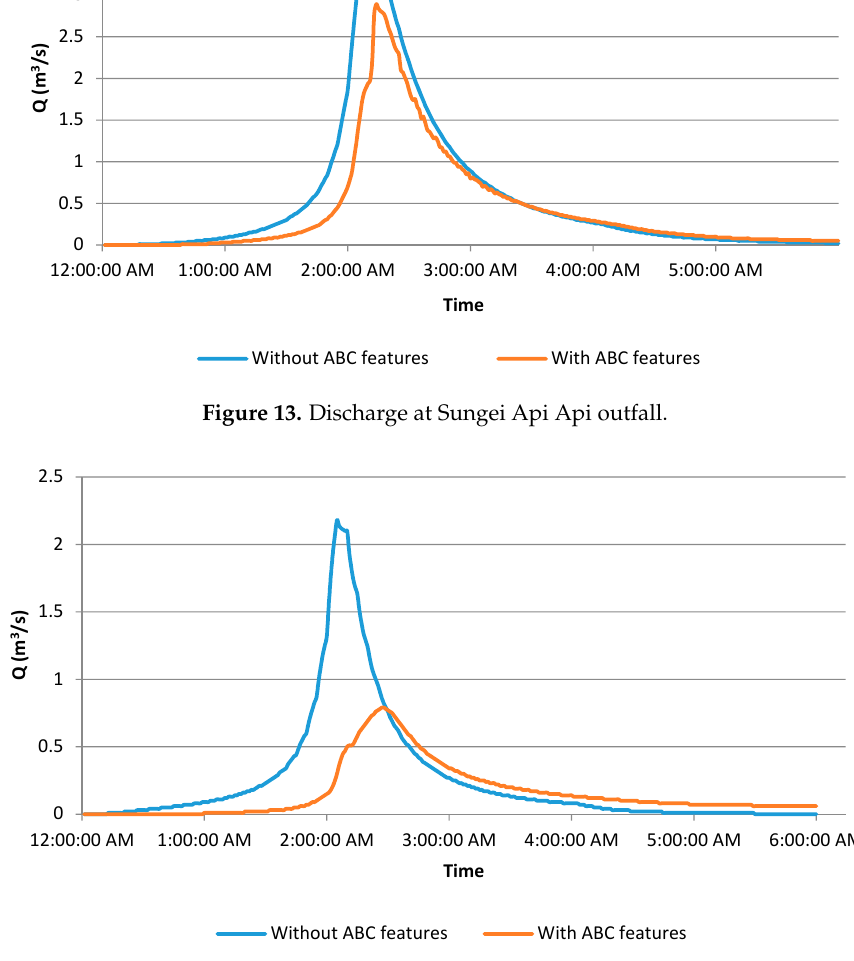
Figure 14. Discharge at Sungei Peng Siang outfall.